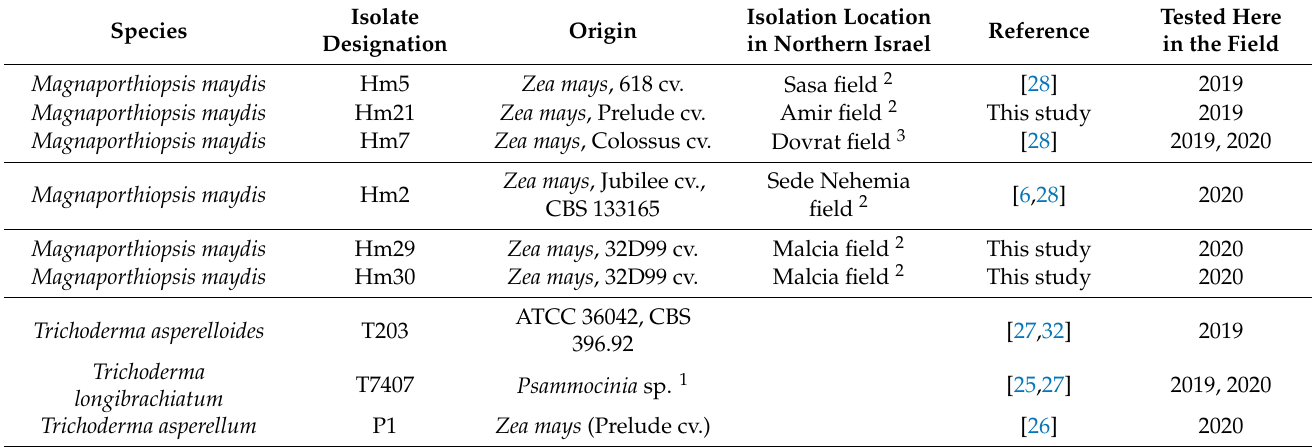
Table 1. Fungi used in this